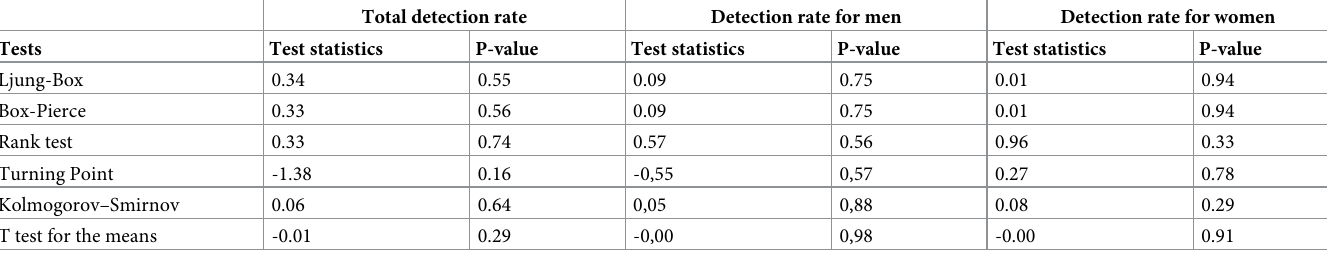
Table 2. Analysis of residuals of temporal modeling of detection rates, Imperatriz, MA, Brazil (2006–2016).